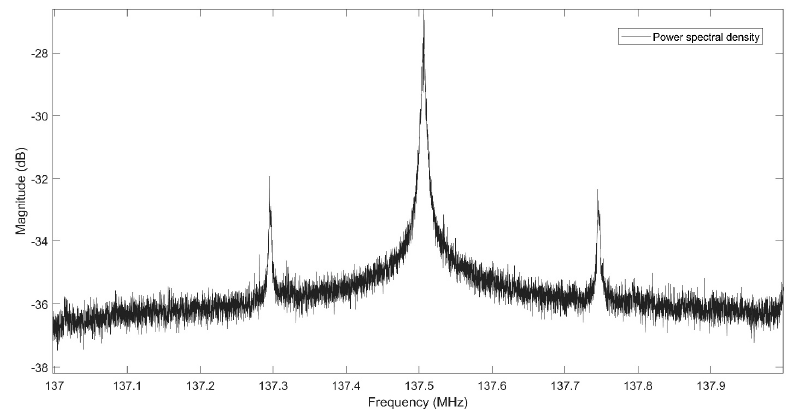
Figure 8. Power Spectral Density (PSD) analysis of acquired Orbcomm signal.